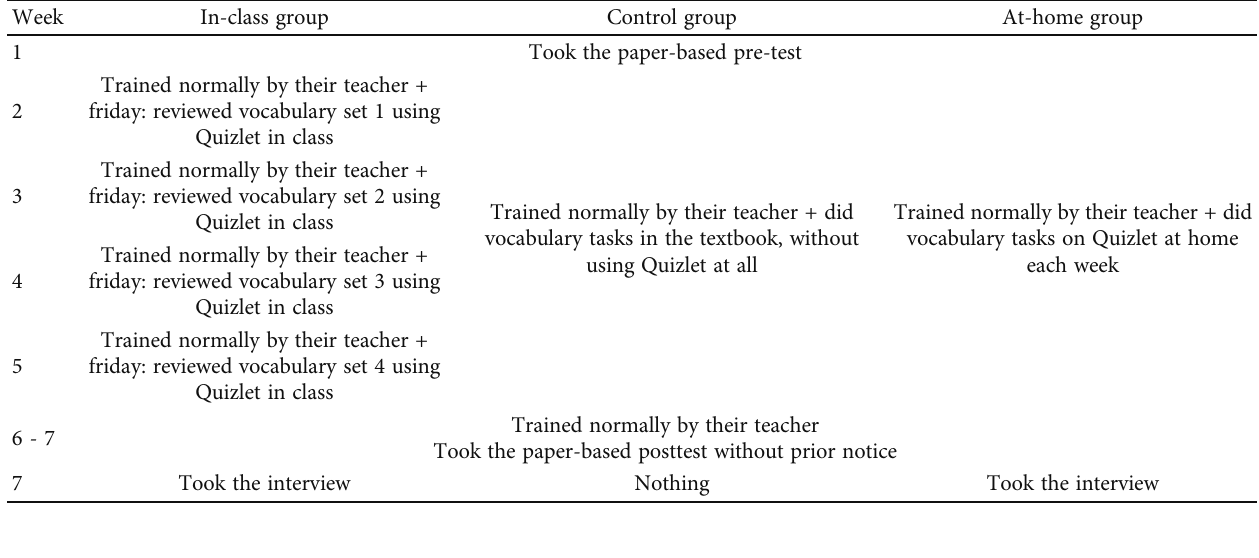
Table 4: Fixed e ff ects from the GLMM.